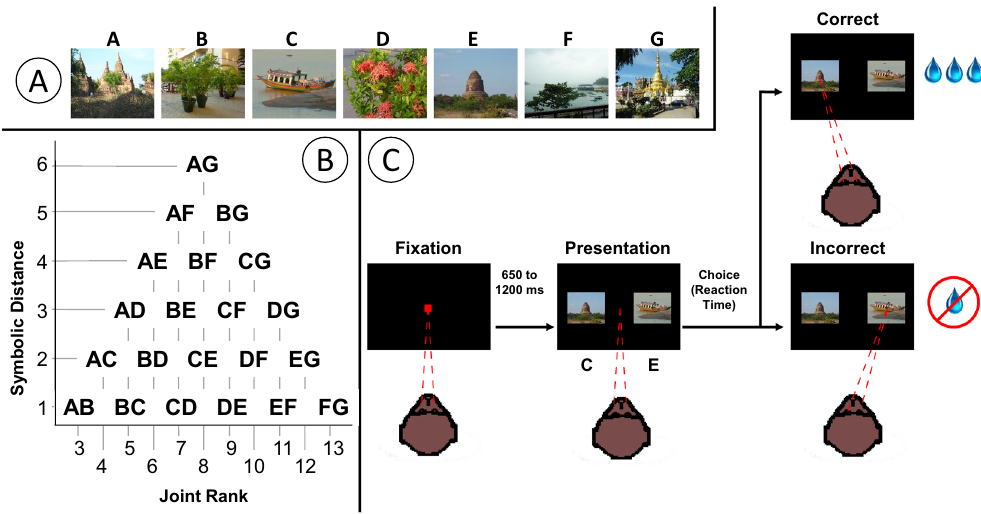
Figure 7. Transitive inference task procedure. ( A ) Example of a list of 7 random images assigned ranks A thru G. ( B ) All 21 image pairs for a 7-item list, and their respective joint ranks and symbolic distances. ( C ) Trial structure and